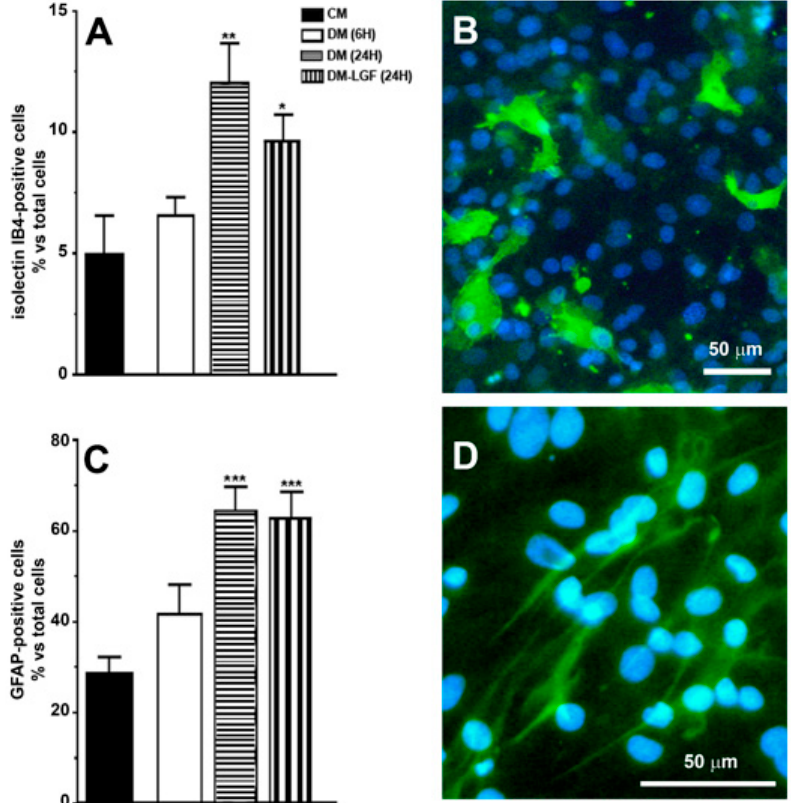
Figure 2. Immunocytochemical characterization of cultures of mesencephalic glia. ( A , C ) show the percentage of immunopositive cells for isolectin IB4 and anti-glial acidic protein (GFAP), specific markers for microglia and astrocytes, respectively. ( B ) shows the immunodetection for isolectin IB4 (green), and ( D ) for GFAP (green). Cell nuclei were stained with Hoechst (blue). In ( A , B ), the results represent the mean ± SEM of 8 coverslips from 2 independent experiments. CM (complete medium), DM (defined medium), DM-LGF (defined medium with liver growth factor). * p ≤ 0.05, ** p ≤ 0.01, *** p ≤ 0.001 vs. CM. Scale bar 50 µ